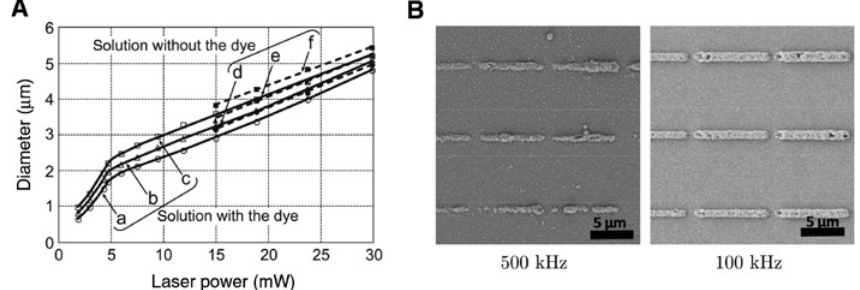
Figure 5: Influence of